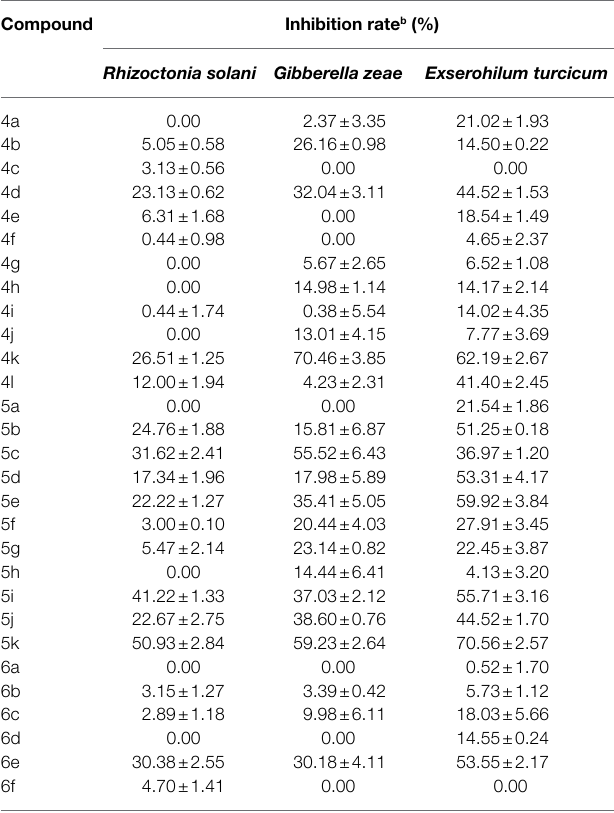
TABLE 1 | Antifungal activities of oxadiazole derivatives in vitro at 50 μ g/ml. a